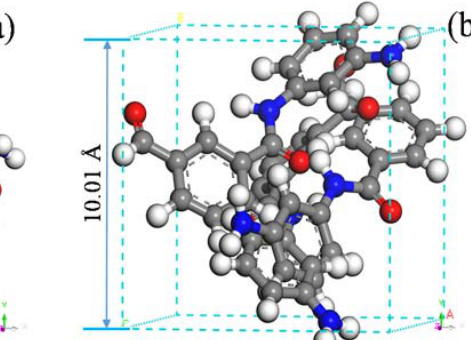
Figure 1. Molecular elemental structure of meta ‐ aramid fiber.